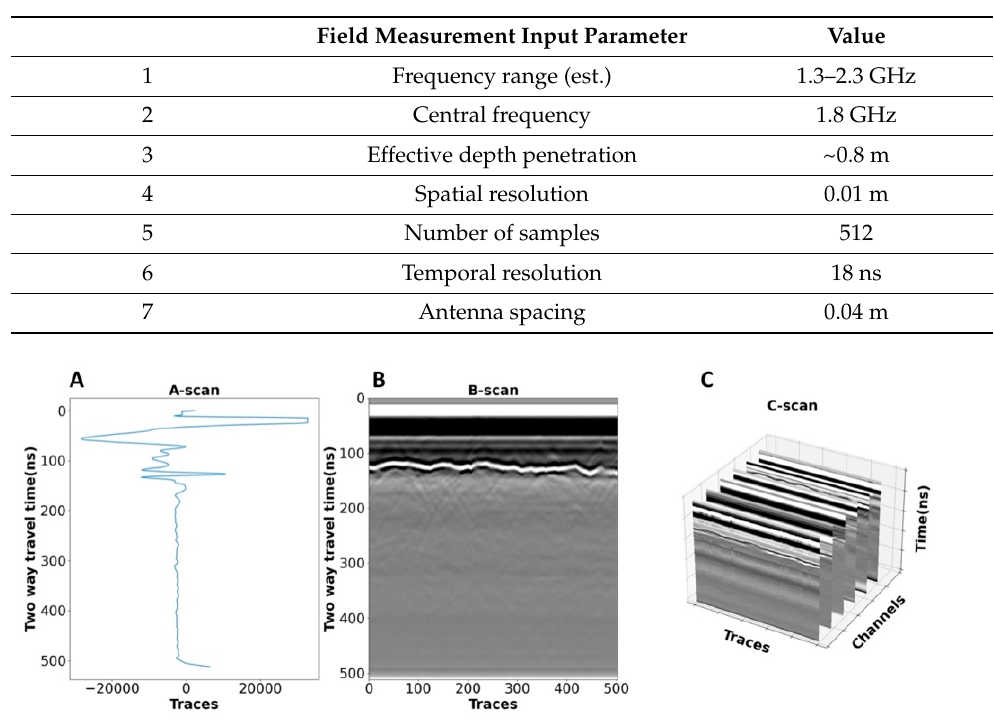
Figure 2. GPR radargram visualization: ( A ) A-scan representing the signal received via a single outgoing pulse at a given transmission–reception antenna’s location; ( B ) B-scan representing the series of A-scan pulses from a single antenna transect; and ( C ) C-scan representing collection of B-scans. Adapted from